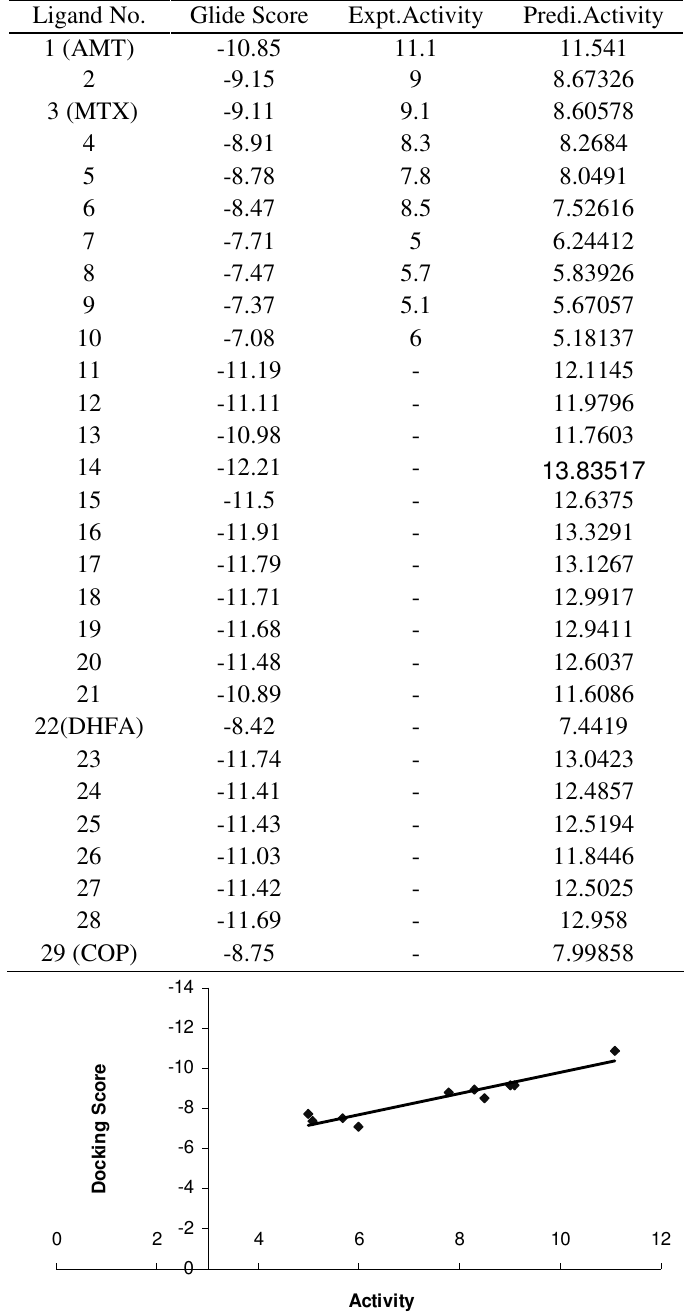
Plot of docking scores Vs Activity